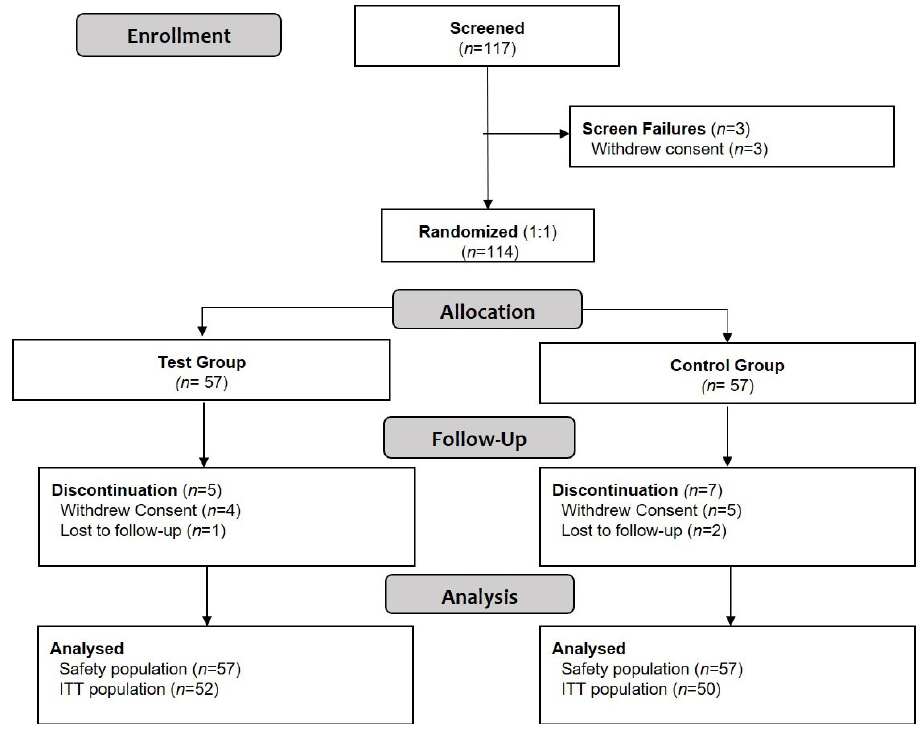
Figure 1. Consort diagram. ITT: intent-to-treat. Table 2. Demographics, nutritional status, and baseline